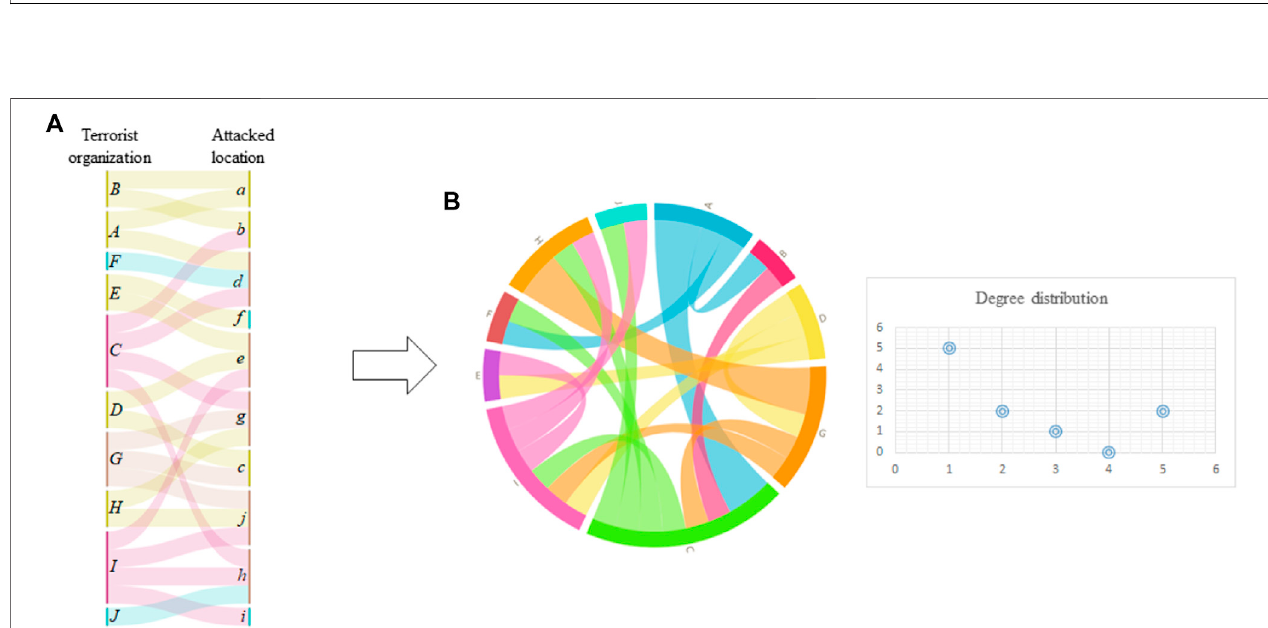
FIGURE 1 | The number of countries suffering from terrorist attacks from terrorist organizations: In this map, there are 15 levels (from 1 to 15). If the number of attacks is fewer than 100, the level is 1; if the number of terrorism attacks is more than 100 and fewer than 200, the level is 1. Thus, the corresponding level will be increased by 1 if the number of terrorism attacks is increased by 100.